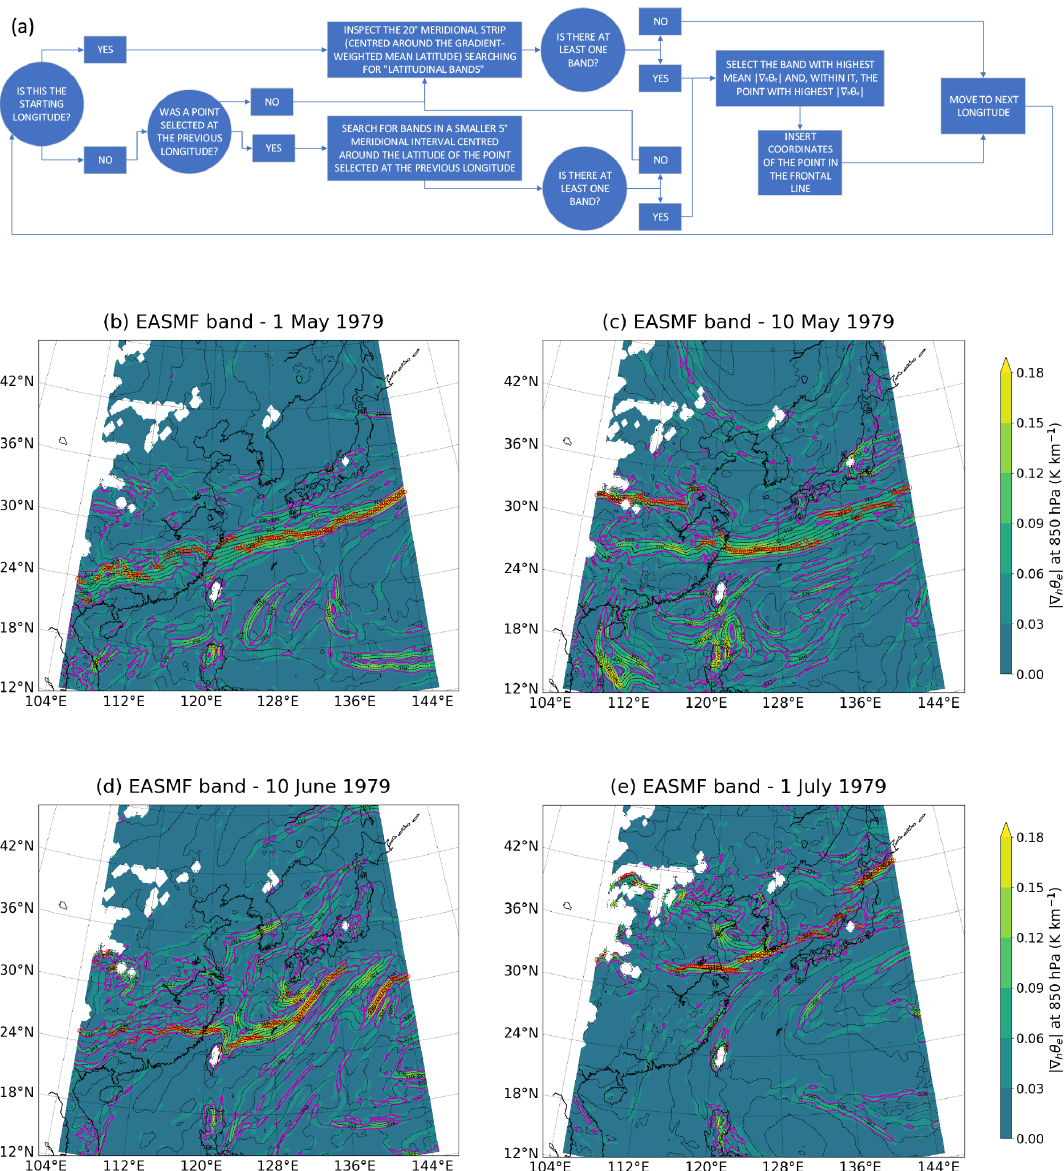
Figure 1. (a) Flow chart of the front-detection algorithm applied at each longitude in the domain to draw daily EASM frontal lines. (b– e) EASMF daily locations on the indicated dates. Empty red dots indicate the coordinates of the points constituting the frontal line, shading indicates | ∇ h θ e | (Kkm − 1 ), magenta contours enclose regions exceeding | ∇ h θ e | threshold (0.05Kkm − 1 ), and black dashed contours indicate θ e (every 3K, labelled every 6K only in above-threshold regions). All values are masked out at levels below the ground. Data from